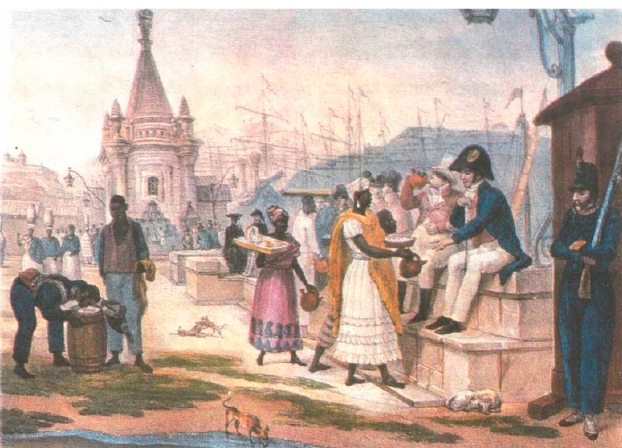
Figure 2. Debret’s work of art named “An afternoon at the Palace Square” (1826) [7].